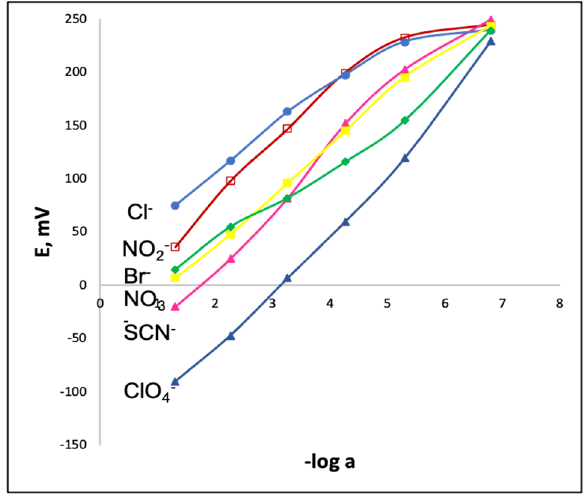
Figure 5. Calibration curves for membrane Mb2 containing CoTPP-N and 20 mol% of TDMACl. Measurements were performed in MES buffer background, pH 5.5.